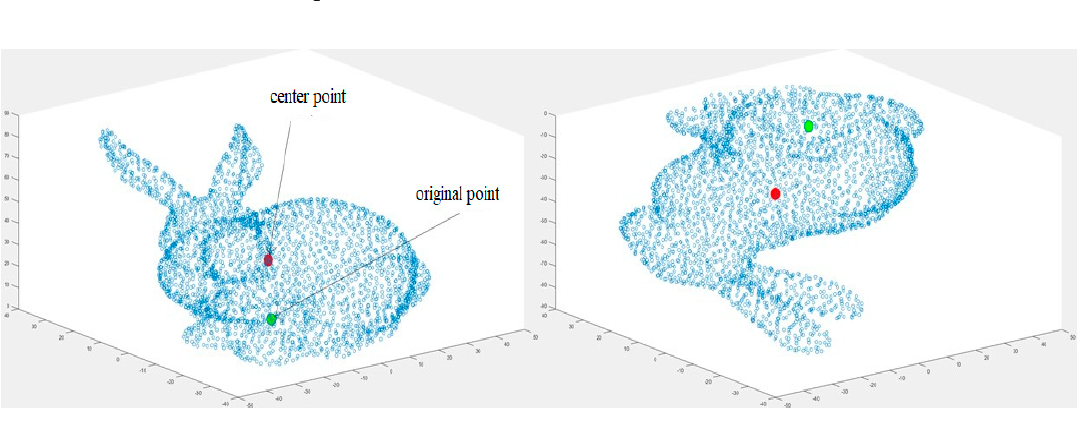
Figure 5. 3D rotation: The original model in the left and the rotated model in the right. Blue point: The vertex of 3D mesh. Red point: The center point. Green point: The original point (0, 0, 0).